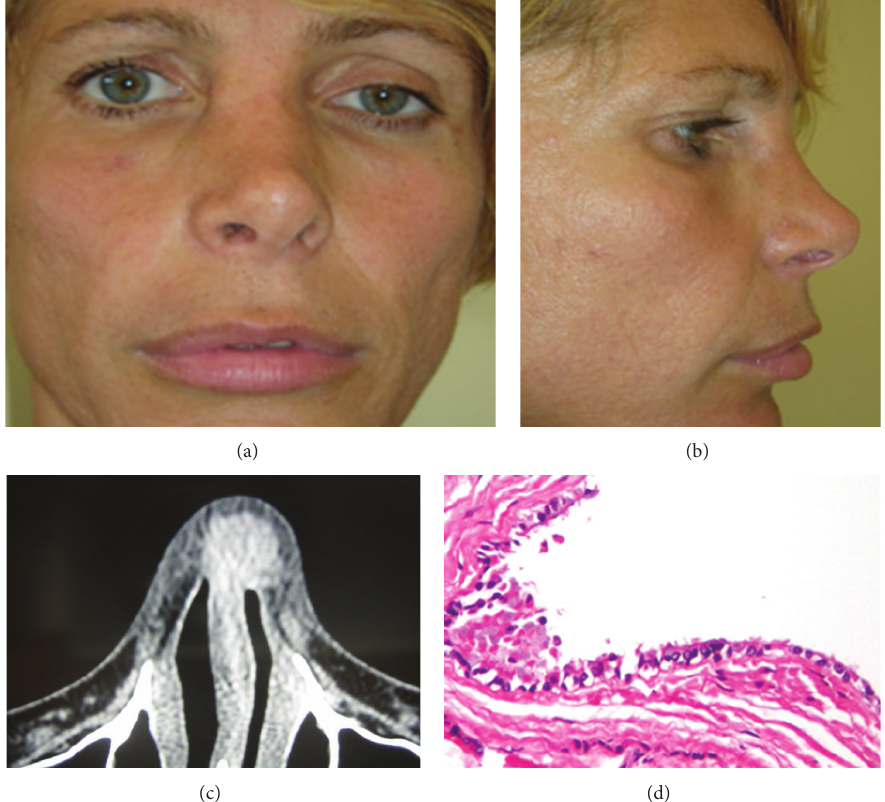
Figure2:(a)Frontalview(Patient#2),(b)lateralview(Patient#2),(c)preoperativeCTscan(Patient#2),and(d)pathologyspecimen(Patient